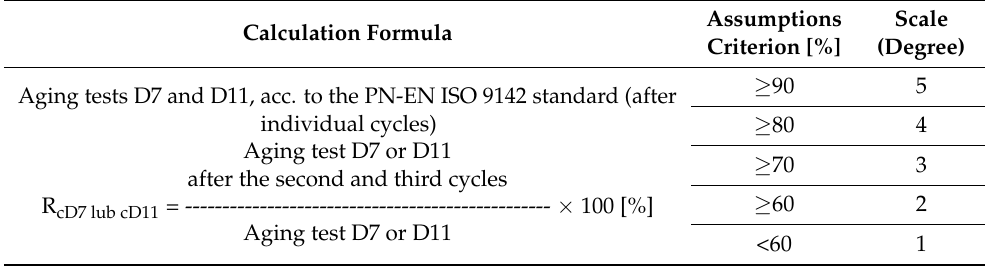
Table 4. Scale for estimation of the resistance of glue lines after aging tests. Calculation Formula